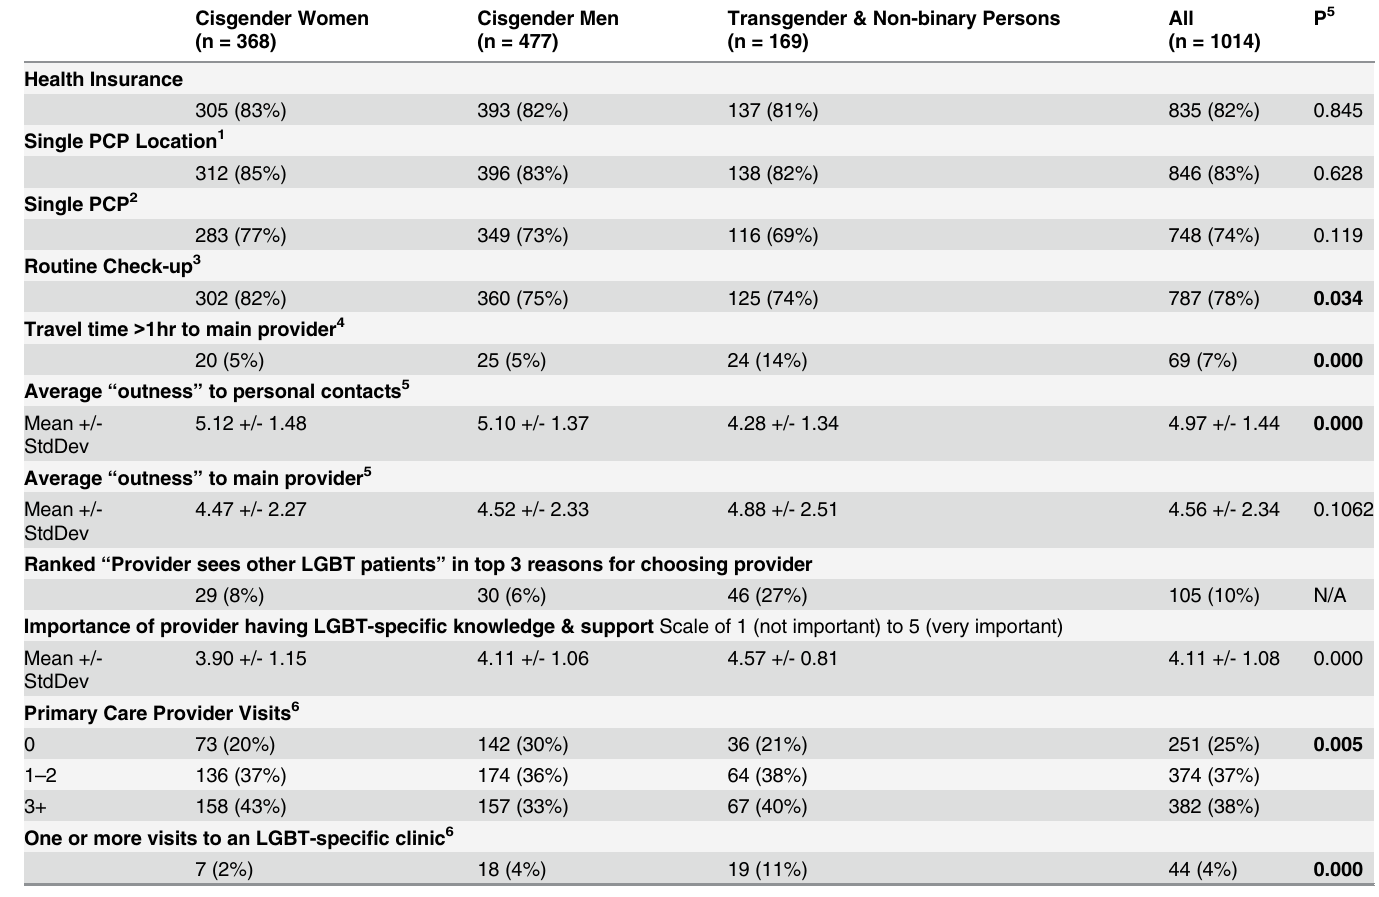
Table 2. Reporting of Health Care Access and Utilization of an online sample of rural LGBT